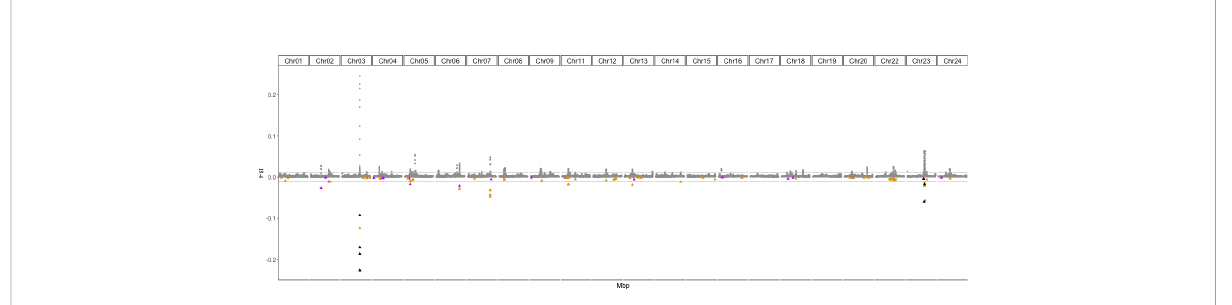
FIGURE 2 Genome-wide Fst differentiation estimated between fi sh from the Gulf of Saint Lawrence and the Northwest Atlantic in sliding windows of 25 Kb within each chromosome (sex-linked chromosomes, Chr 10 and Chr21 (Ferchaud et al., 2022) have been removed. Horizontal grey lines indicate Fst values of 0.01 and -0.01. Colored triangles correspond to outliers found in association with environmental variables by the RDA and LFMM (fdr = 0.0001) approaches. For clarity, Fst values of those SNPs have been reported in negative values as triangles. Purple triangles correspond to sliding windows containing SNPs found in association with bottom dissolved oxygen, those in yellow correspond to the sliding windows presenting SNPs associated with temperature-related variables. Black triangles identify sliding windows containing SNPs putatively in association with both the bottom dissolved oxygen and temperature-related variables and non-outliers in dark grey